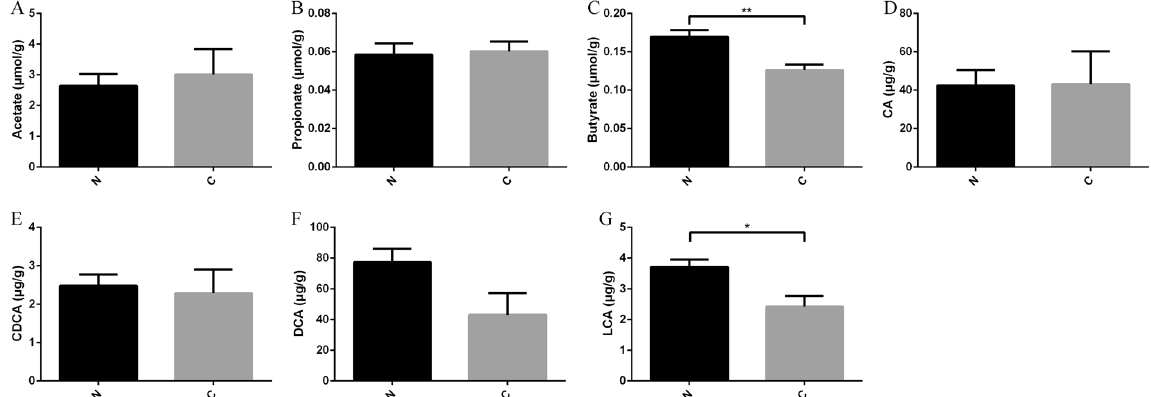
Figure 5. Transplantation of microbiota from STC donors altered host metabolism in colon (Group N = 5, Group S = 5). SCFAs (acetate, propionate and butyrate) ( A – C ), primary BAs (CA and CDCA), and secondary BAs (DCA and LCA) levels ( D – G ) change in mice receiving fecal microbiota from STC donors. Data represent the mean ± SEM. * p < 0.05, ** p < 0.01. Group N: mice receiving fecal microbiota from healthy donor; Group C: mice receiving fecal microbiota from STC donors. STC: slow transit constipation; SCFA, short chain fatty acids; CA, cholic acid; CDCA, chenodeoxycholic; DCA, deoxycholic acid; LCA, lithocholic acid.